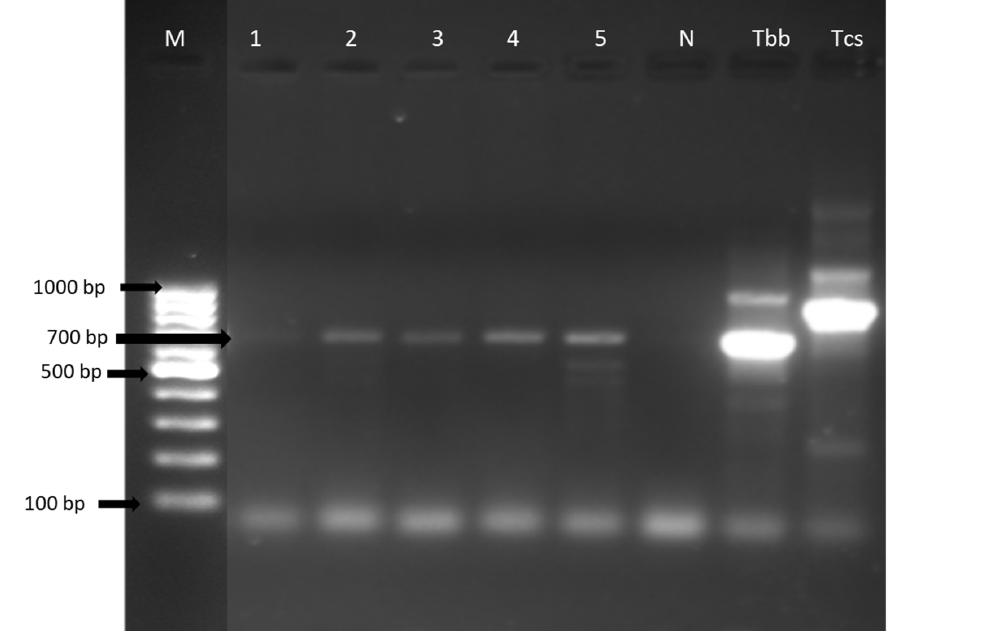
Figure 2. 1.7% agarose gel electrophoresis image showing a 700 bp band for the PCR amplification of Internal transcribed spacer- 1 (ITS-1) region of the 18Sribosomal RNA gene of Trypanosome species Lane M: 100 bp DNA Marker (Bioline); Lane 1: Negative horse sample; Lanes 2 - 5: positive horse samples; Lane N: Negative control (no DNA template); Lane Tbb ( Trypanosoma b. brucei ) J10: positive test control; Lane Tcs ( Trypanosoma congolense savannah ) WG81 positive test control. Bands were visualized by staining with ethidium